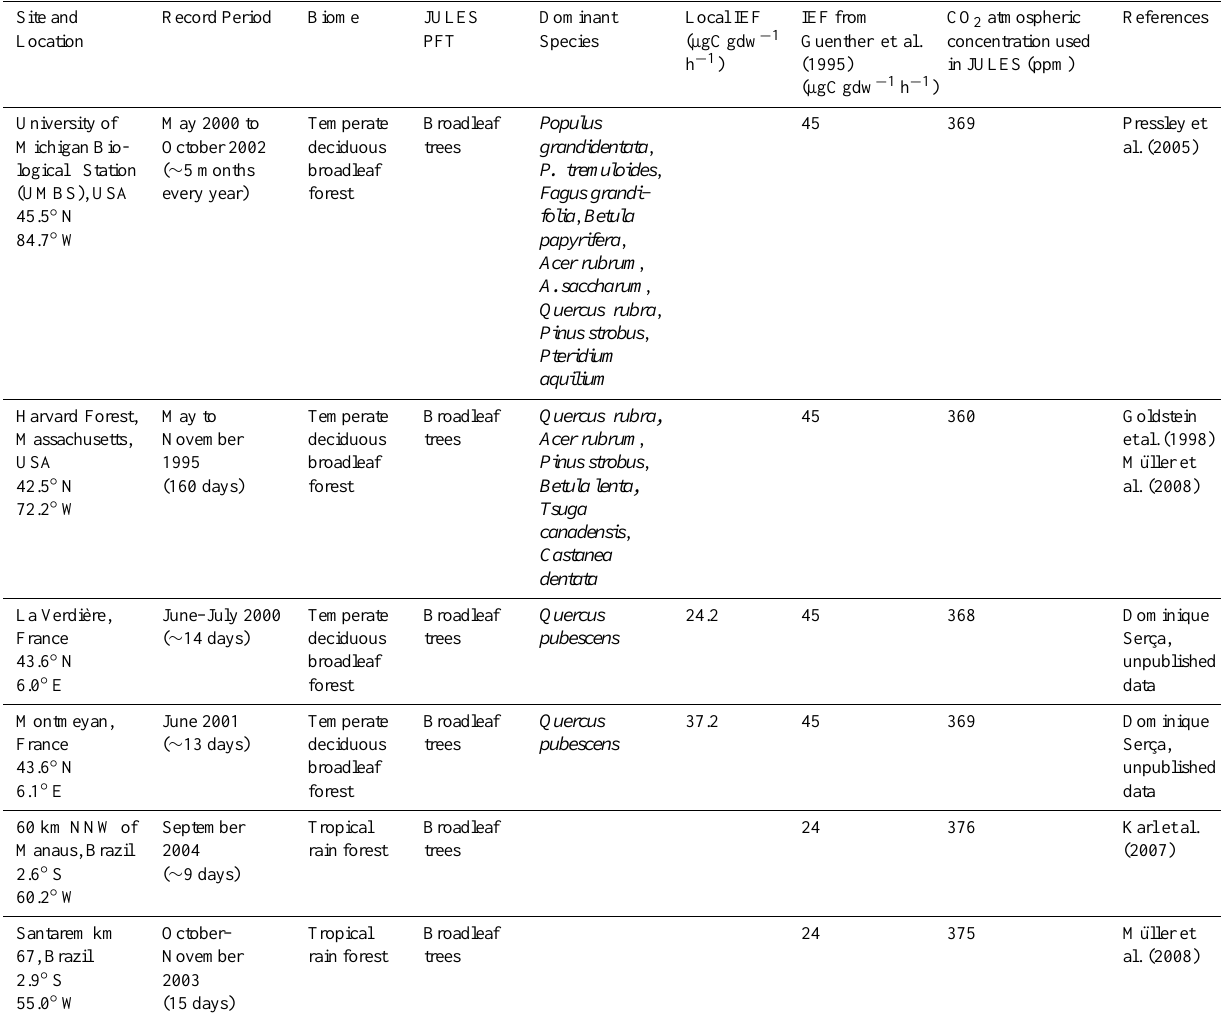
Table 1. Description of ground-based isoprene flux tower